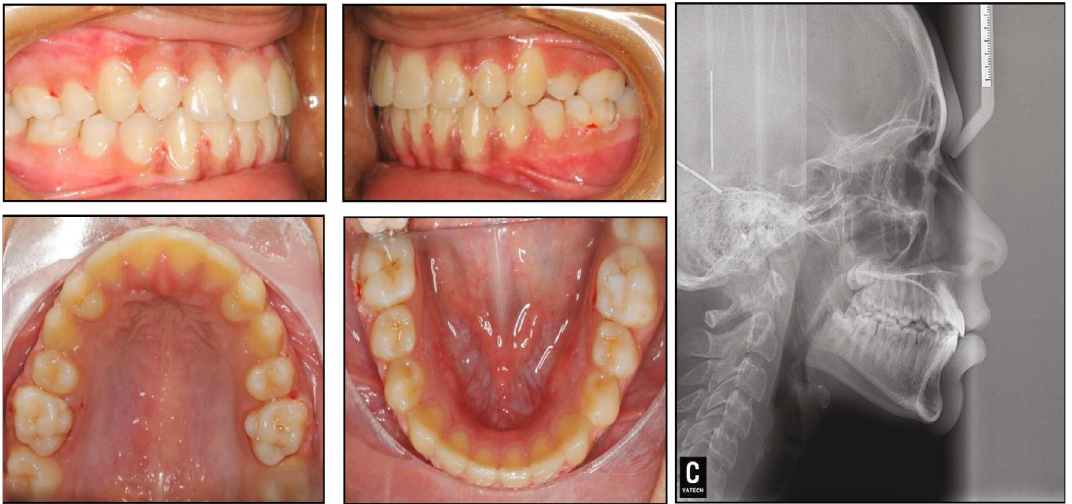
Figure 12: Posttreatment clinical photographs and lateral cephalogram.